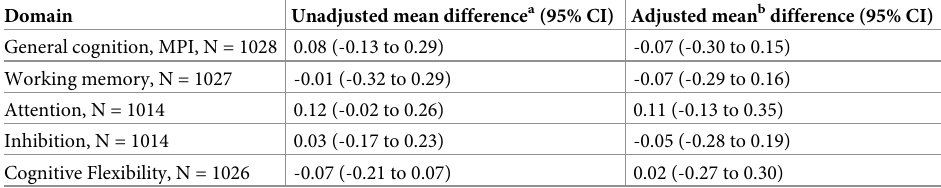
Table 3. Neuro-psychological testing results from KABAC II (General cognition, MPI and Working memory), T. O.V.A (attention and inhibition) and CCT (cognitive flexibility). Country-pooled results showing linear regression unadjusted and adjusted models with trial arm as the dependent variable.